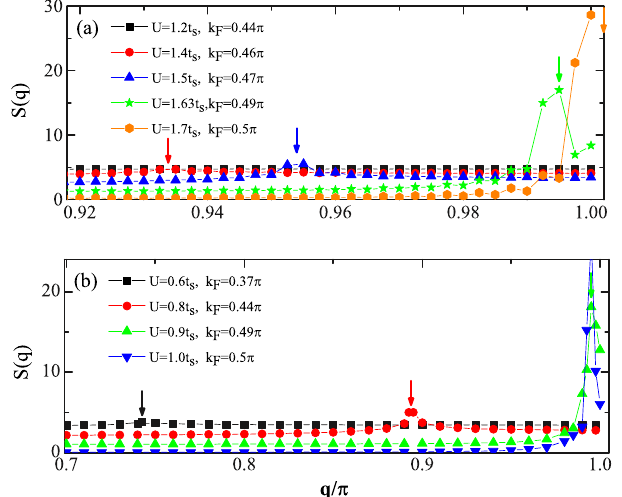
Figure 4. Charge structure factor S ( q ) of the Majorana ladder. The structure factor of the charge-charge correlation on the interacting Majorana ladder at ( a ) t 1,2 = 0, t d = 0.2 t s and ( b ) t 1,2 = 001 t s , t d = 0.4 and various interaction strength (data are vertically shifted in arbitrary units for a clear view). The size is L = 400. The arrows point out the location of